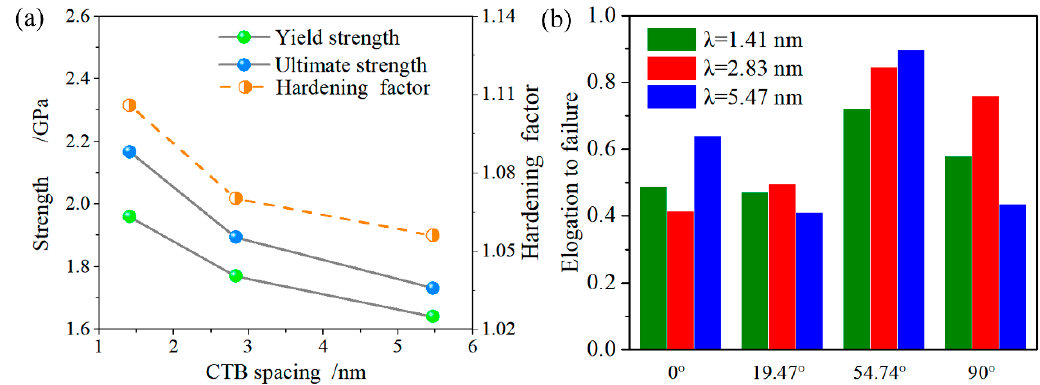
Figure 5. ( a ) The yield strength, ultimate strength, hardening factor as a function of twin spacing for the NT nanowires with θ = 54.74°; and, ( b ) elongation to failure versus twin orientation and spacing.